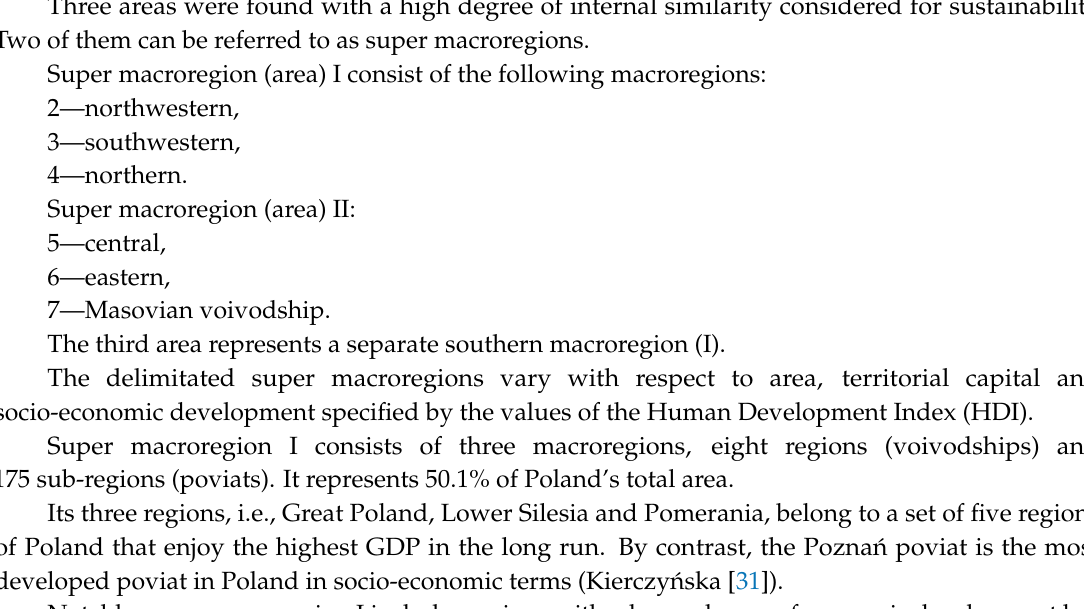
Figure 3. Grouping of macroregions with cluster methods (1—southern, 2—northwestern, 3—southwestern, 4—northern, 5—central, 6—eastern, 7—Masovian voivodship). Source: own compilation. Three areas were found with a high degree of internal similarity considered for